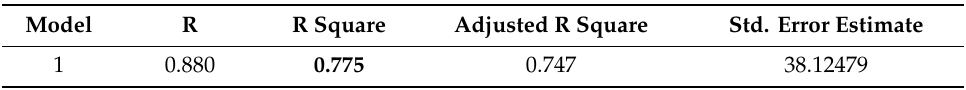
Table 9. The result of Multiple Regression Analysis for parameters from the Price and Market Volatility